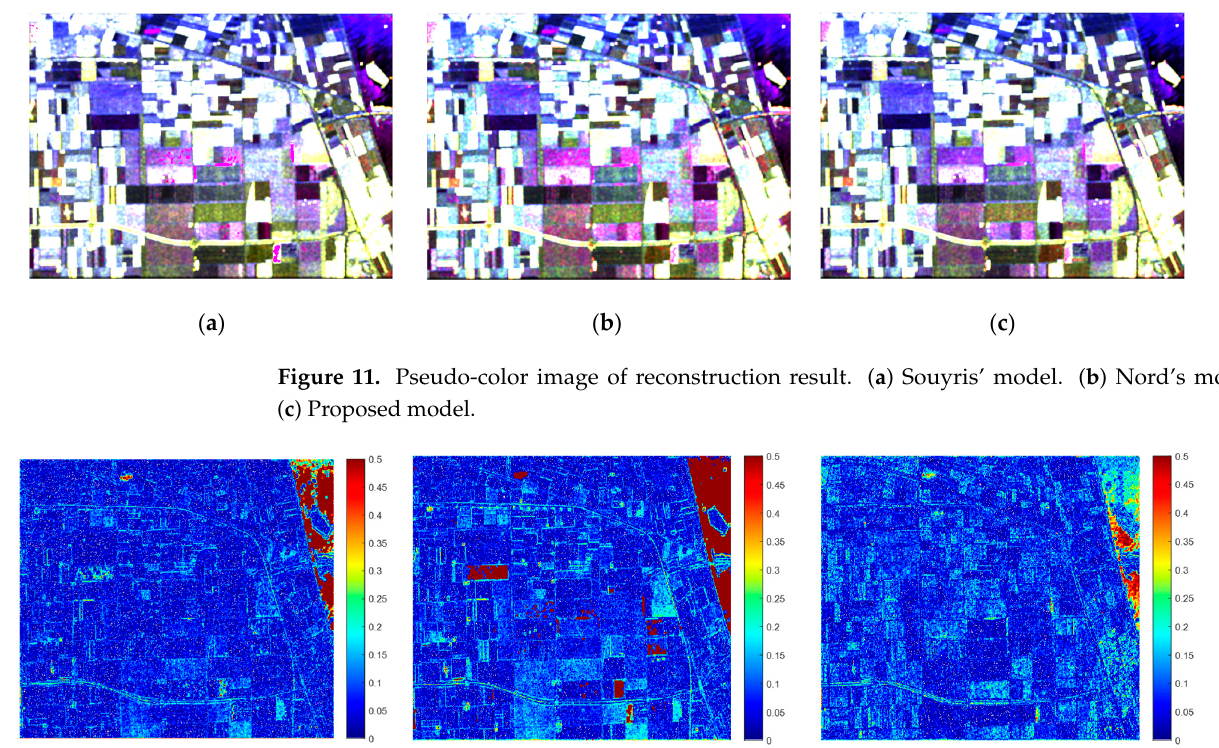
Figure 12. Relative error image of model.